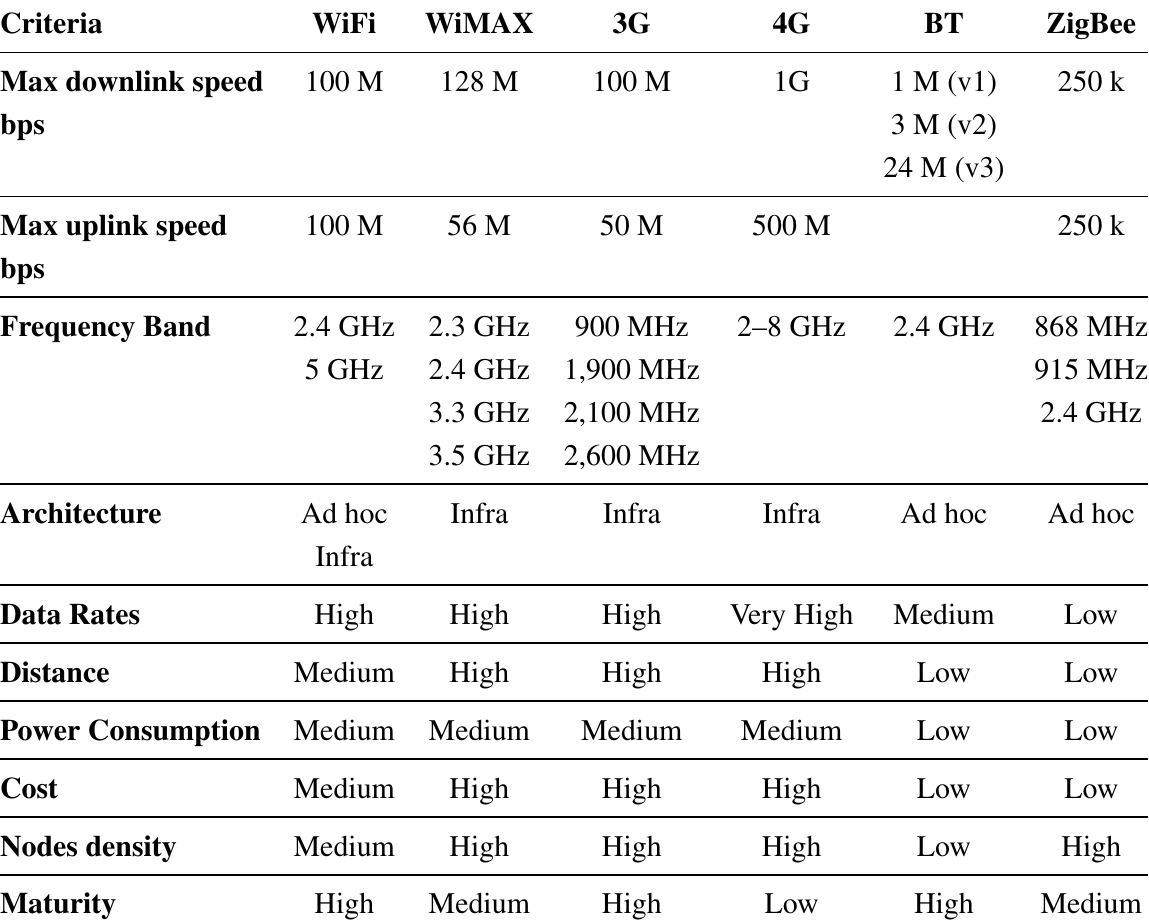
Table 1. Communication Technologies for sensor